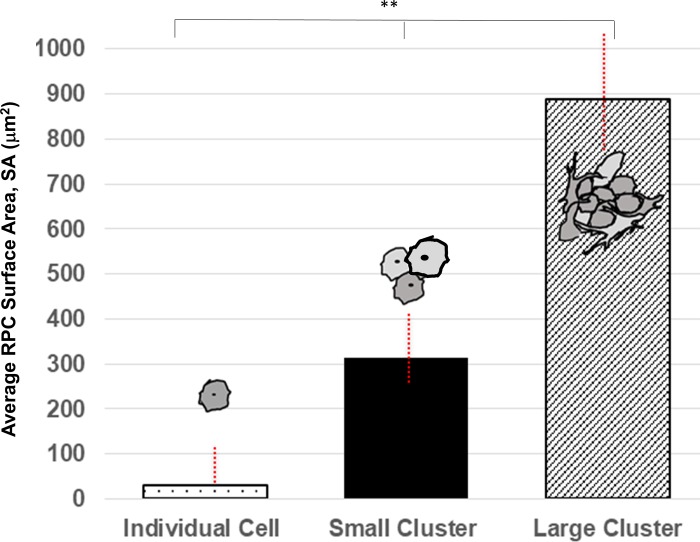
Mean surface area, SA, of retinal progenitor cells (RPCs) adhered as individual cells (IC), small clusters (SC), and large clusters (SC) of RPCs.An individual cell (IC) was defined as one without proximal cell-cell contract, as illustrated by the cell schematic. Small clusters (SC) of RPCs were denoted as groups of 5–15 cells in contact with neighbors on ≥ 75% of its cell membranes, as shown. Large clusters (LC) of RPCs were denoted by similarly interconnected groups of more than 15 cells, as per accompanying schematic. Statistical significance (** p < 0.01) was measured across all groups.